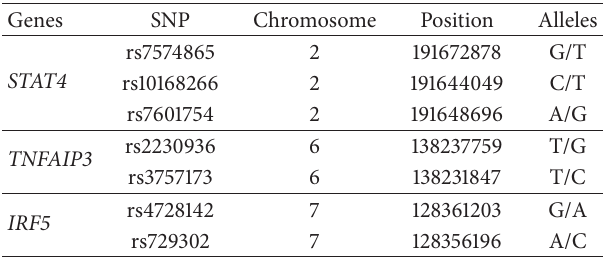
Table 2: SNPs that were investigated in this study on their associa- tion with